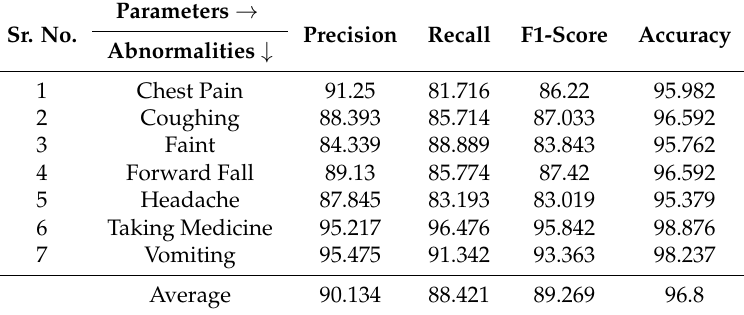
Table 5. Performance evaluation of dataset with the ratio of 70:30.